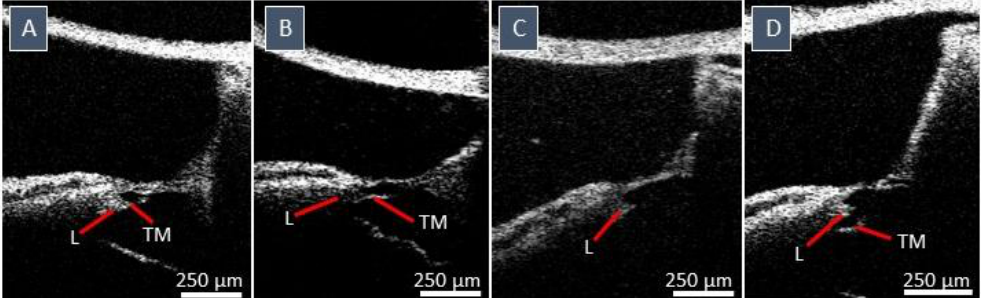
Figure 5. Different shapes, sizes, and orientations of the tectorial membrane (TM). ( A ): the TM in the original position, covering the medial part of the sensory epithelium. ( B ); clear distortions in the shape of the TM. ( C ): the TM disappeared. ( D ): the TM altered towards the SM; however, it must not be confused with the spiral limbus, which got loosened in these images. A-scan rate: 76 kHz Abbreviations: Tympanic membrane (TM) and spiral limbus (L).